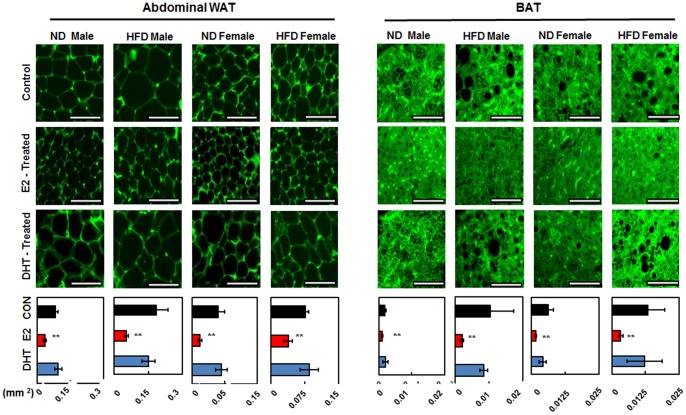
Dietary and hormonal effects on morphologies of abdominal WAT and BAT using immunofluorescence of CAV1-FITC.Scale bar represents 100 µM and 50 µM, respectively. Adipocyte area or lipid area between control and hormone treated groups were calculated by Student’s t-test, where, *p<0.05 and **p<0.01. The significance of the effects of sex, diet and hormonal treatments was tested using multivariate ANOVA (M-ANOVA), where p<0.05.